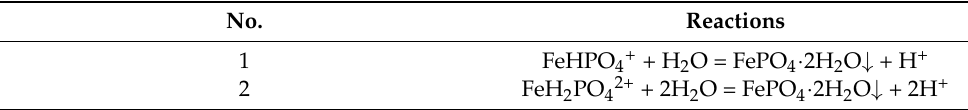
Table 4. Possible reactions in solution with an initial pH value of 0.85.